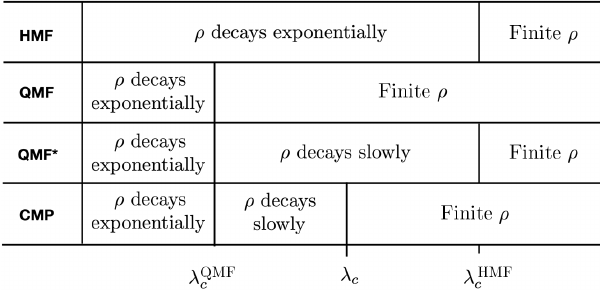
FIG. 7. Behavior of SIS prevalence ρ according to the different approaches. QMF* stands for the QMF theory as reinterpreted in Refs.